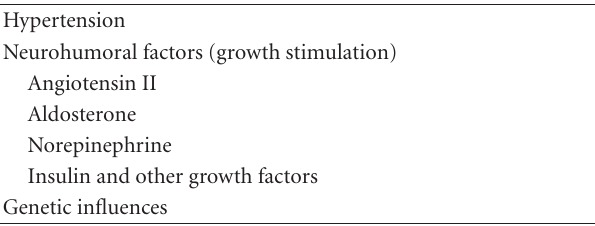
Table 1: Factors promoting left ventricular